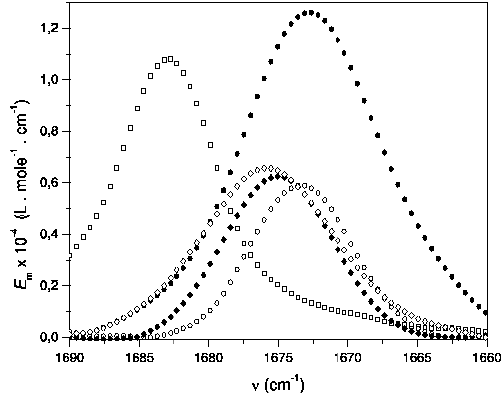
Figure 2. IR Carbonyl Band Behavior of Acetylferrocene in Some Aprotic Solvents: